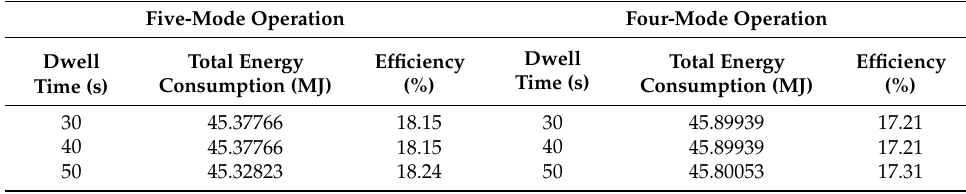
Table 4. Total energy consumption under different dwell times of 1st